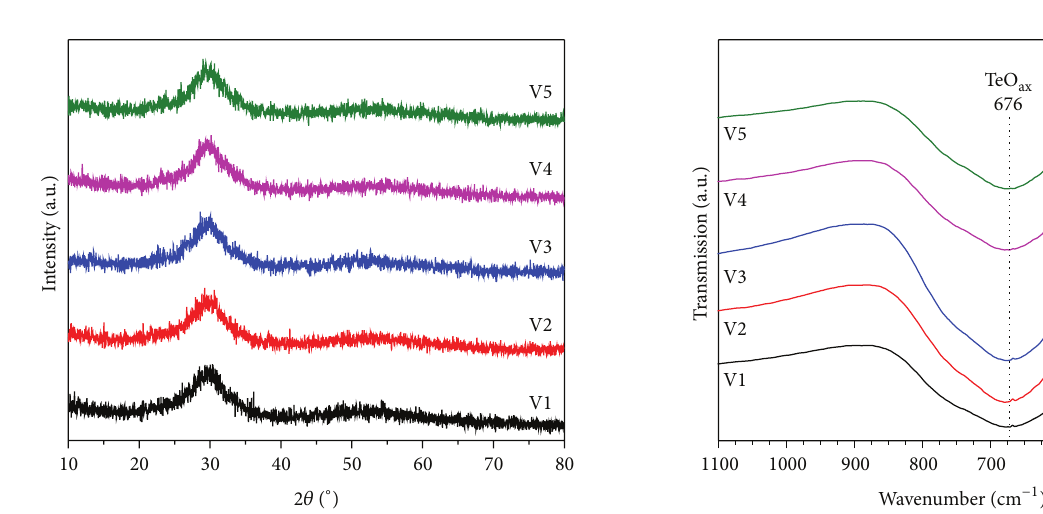
Figure 2: Diffraction patterns of all fabricated glasses. It can be seen that all the samples are amorphous.